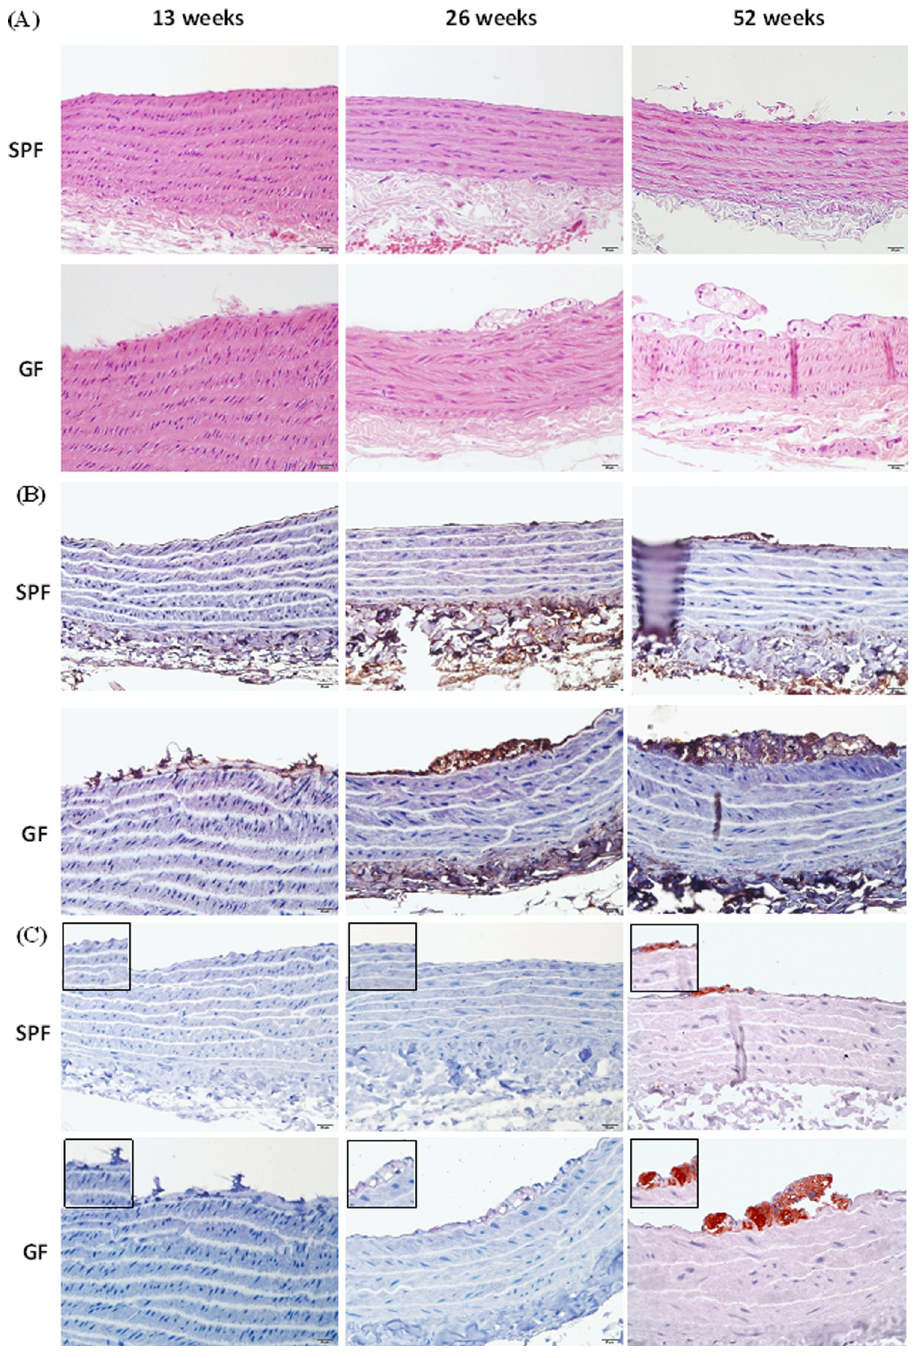
Fig 2. Histopathology and immunohistochemical staining of thoracic aorta lesions. (A) H&E stain. (B) Endothelium injury (Von Willebrand Factor) staining. (C) Macrophage (anti-CD68) staining. GF: germ free, SPF: specific pathogen